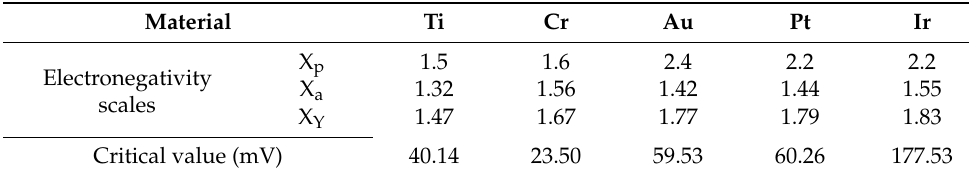
Table 1. Comparison of the electronegativity and critical value of microelectrodes with different surface